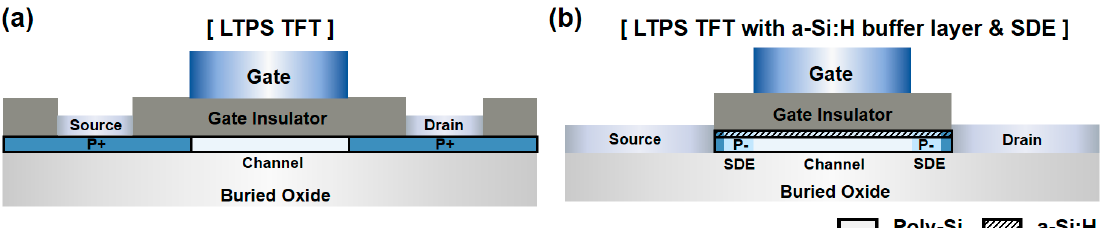
Figure 3. Schematic view of the ( a ) p-type LTPS TFTs and ( b ) proposed p-type LTPS TFTs with an amorphous silicon buffer layer and SDE for TCAD simulation.